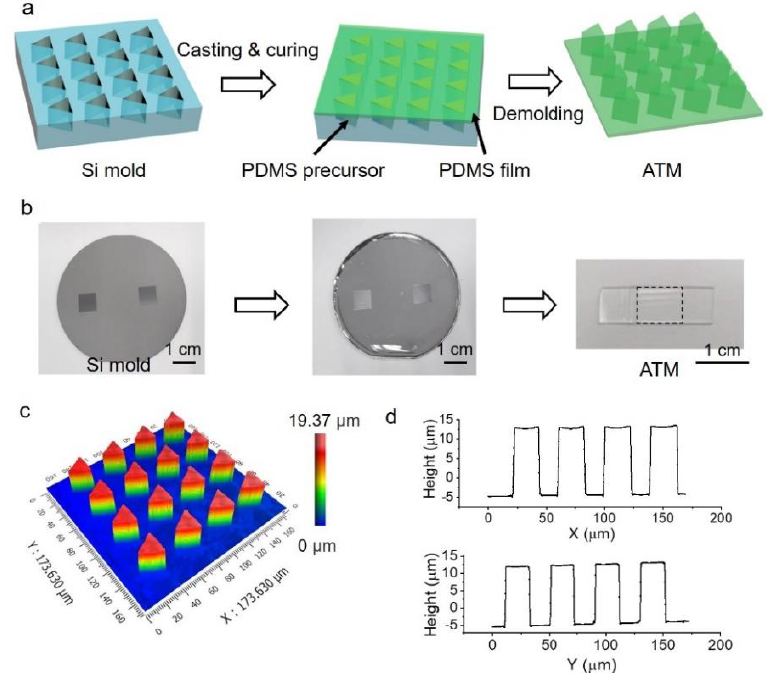
Figure 1. Fabrication of PDMS array of triangular micropillars (ATM). ( a ) Schematic illustration of the fabrication process; ( b ) Optical images of silicon mold, the spreading of PDMS precursor on silicon mold and the resulted sample, the dashed square indicates the location of ATM; ( c ) 3D morphology of ATM; ( d ) Typical profile of ATM along orthogonal directions.